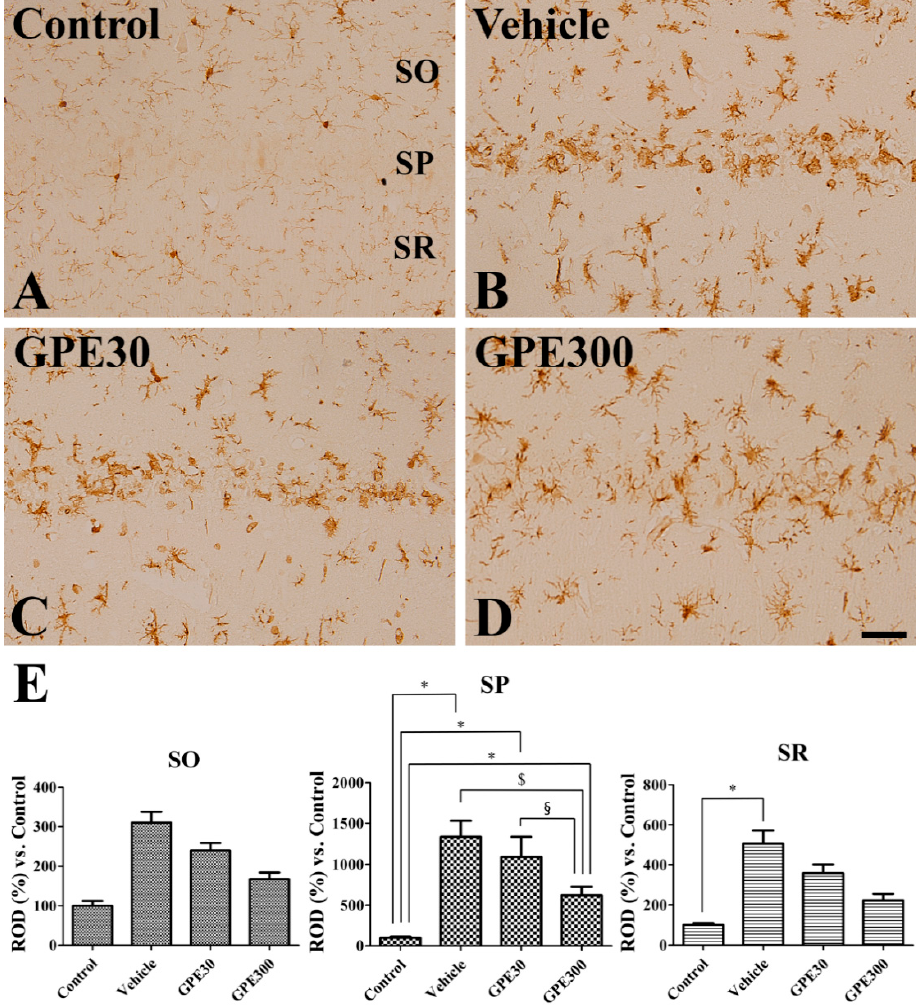
Figure 4. Immunohistochemistry for Iba-1 in the CA1 region of the control ( A ), vehicle-treated ischemic (Vehicle, B ), 30 mg/kg GPE-R-treated ischemic (GPE30, C ), and 300 mg/kg GPE-R-treated ischemic (GPE300, D ) groups. SO, stratum oriens; SP, stratum pyramidale; SR; stratum radiatum. Scale bar = 50 μ m. ( E ) ROD per section in the SO, SP, and SR of hippocampal CA1 region in each group compared with the control group, is shown ( n = 7 per group, * p < 0.05 vs. the control group; $ p < 0.05 vs. the vehicle group; § p < 0.05 vs. the GPE30 group). Error bars represent standard errors of the means.